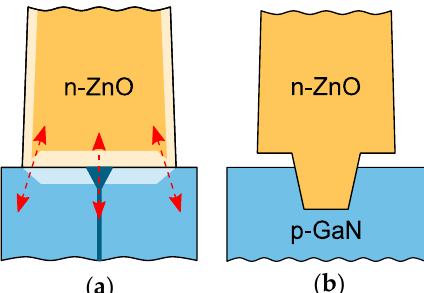
Figure 7. Schematic of the ZnO / GaN interface for the plain and patterned structures. ( a ) The two possible leakage paths through the interface of the plain substrate are depicted—the tunneling through a thinner barrier along the edge of the interface and the leakage caused by the inhomogeneity of the interface and by the extended structural defects of the GaN substrate. ( b ) On the FIB-patterned substrate the leakage current is suppressed, since the ZnO / GaN interface is formed only within the milled trench while the bottom edge of the ZnO nanorod is isolated from the GaN substrate due to lateral overgrowth of ZnO over the growth mask.